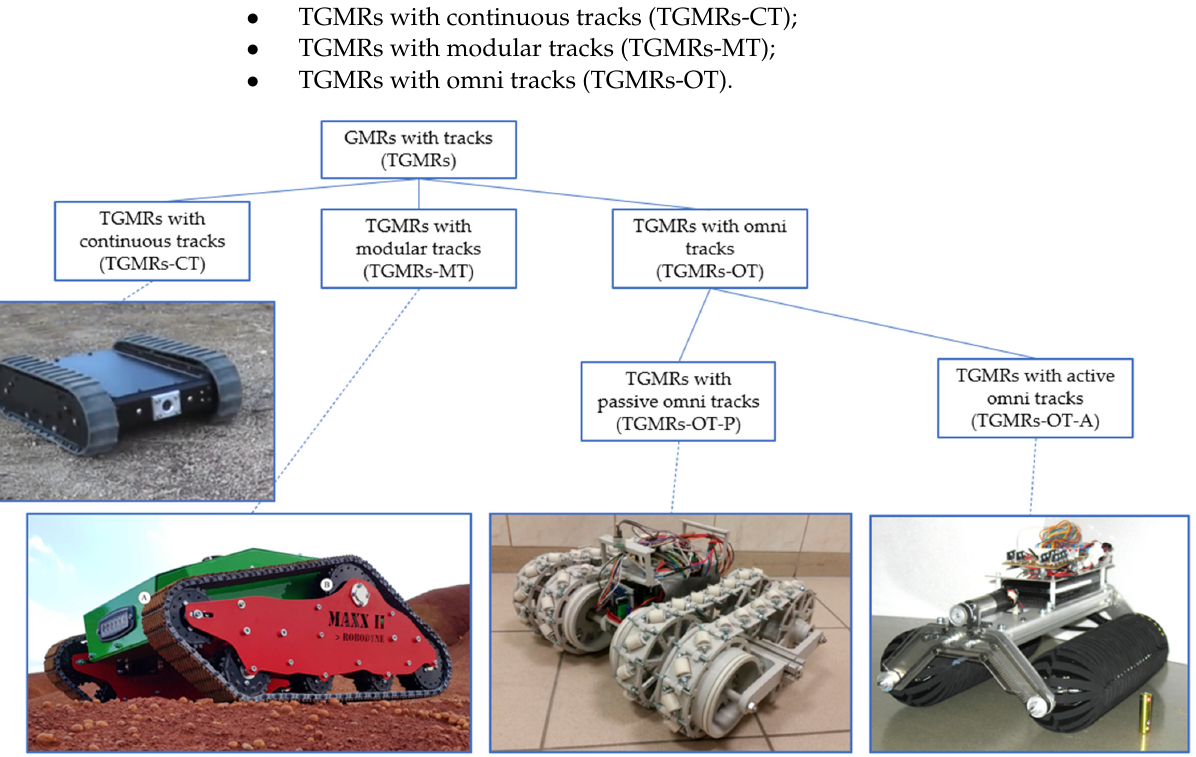
Figure 6. Taxonomy of tracked ground mobile robots based on track type.